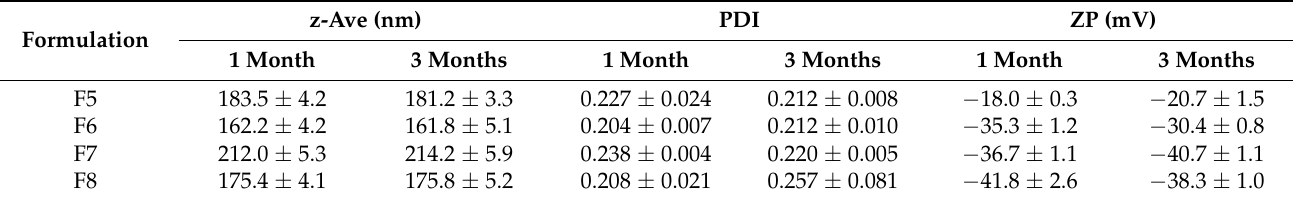
Table 4. Particle size (z-ave), polydispersity index (PDI), and zeta potential (ZP) of nanocrystal dispersions after one and three months of storage (mean ± SD, n =